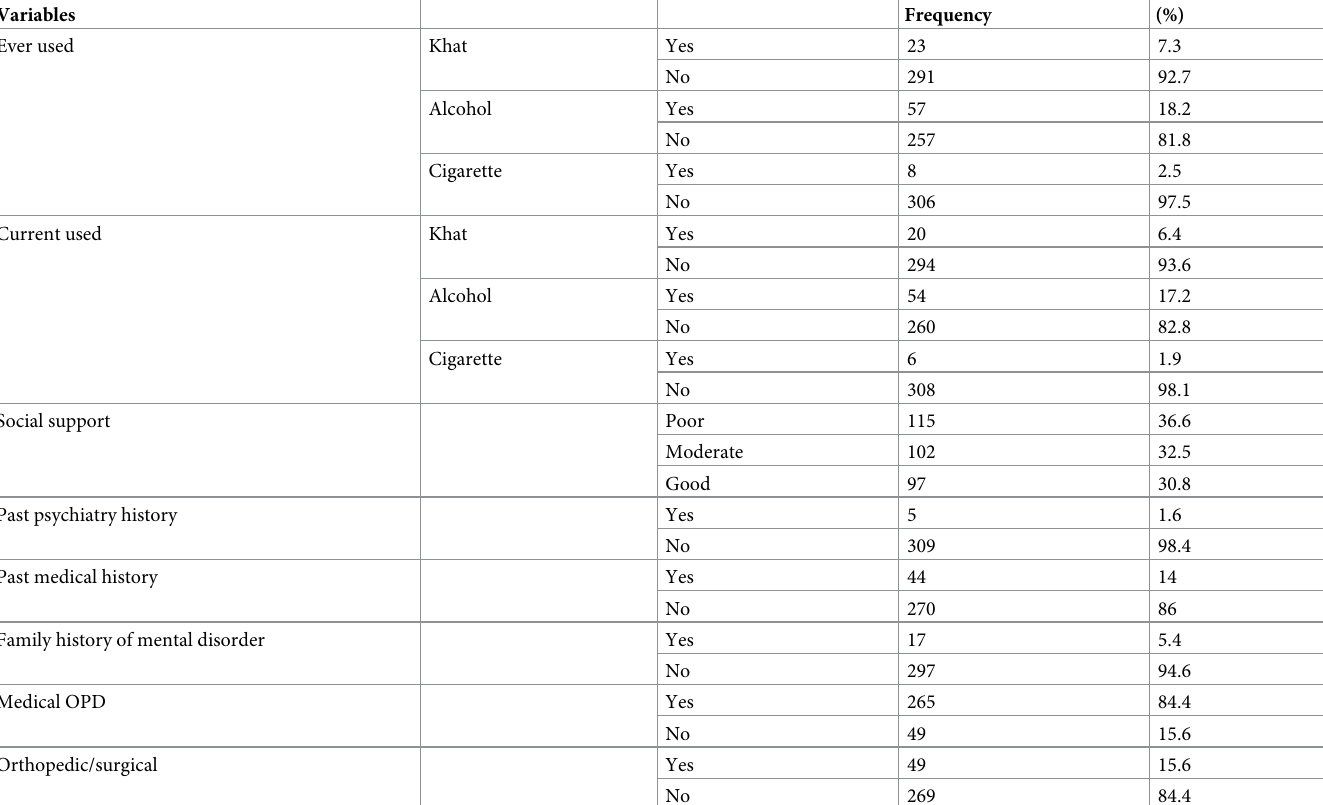
Table 2. Social support and substance use of the study participants at University of Gondar Hospital at Gondar town, Ethiopia, 2019 (n = 314). Variables Ever